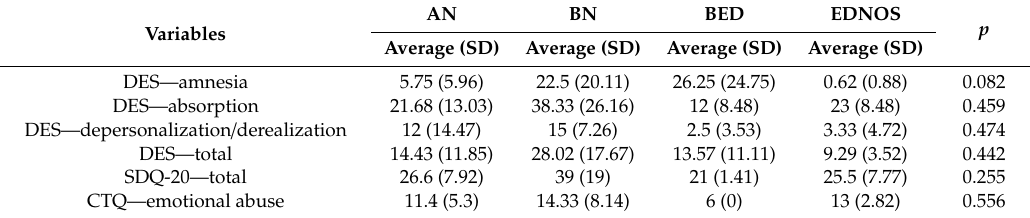
Table 1. Di ff erences between the subtypes of eating disorders as regards the variables: childhood trauma, psychoform dissociation and somatoform